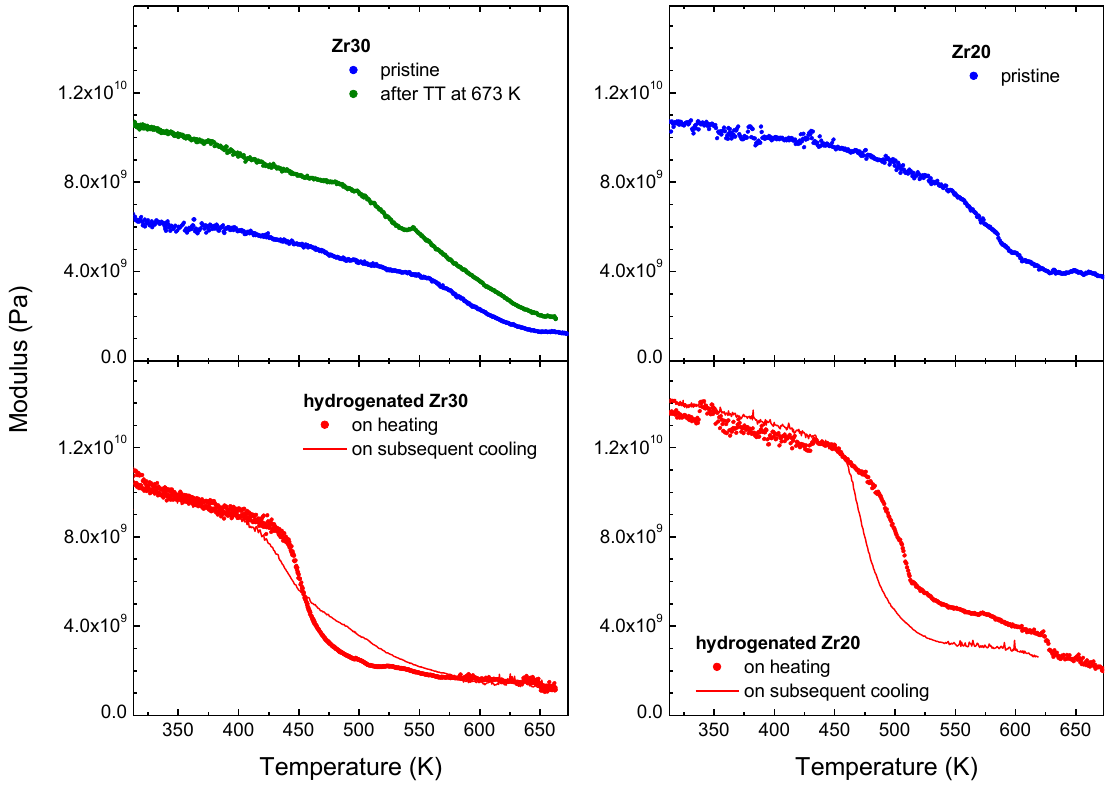
Figure 3. Dynamic Mechanical Analyzer (DMA) measurements of the